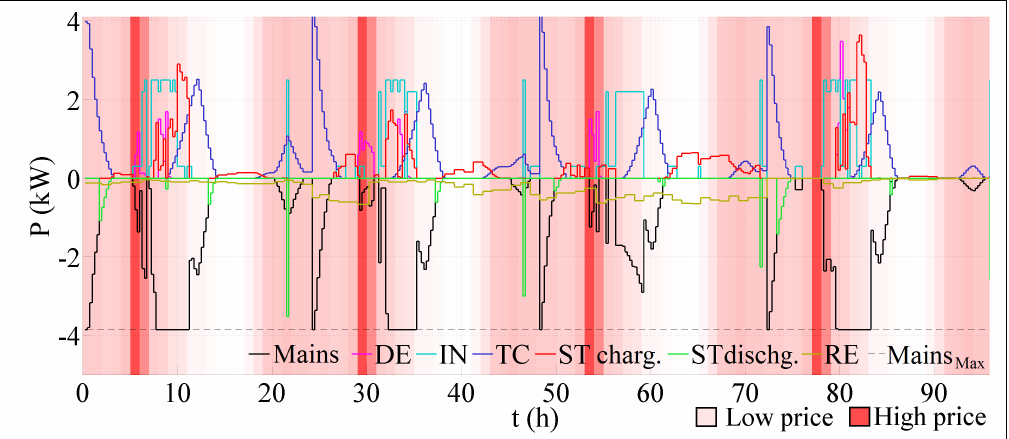
Figure 11. The power balance for the first 96